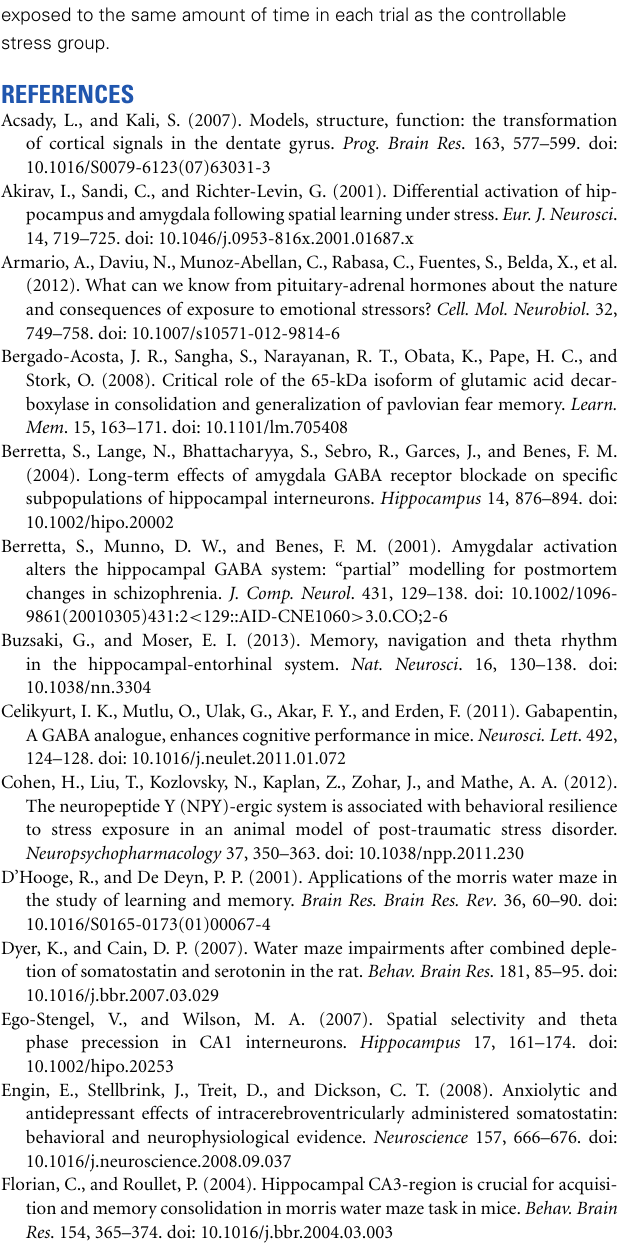
Figure S1 | “Invisible platform” learning curve. Adult male rats ( N = 10) underwent spatial learning in the Morris water maze for locating a hidden underwater platform in 12 trials ( ∼ 60min) with intertrial intervals of 4min. In all trials rats were allowed to search for the hidden platform for 60s at maximum with time measured until animal has reached the platform (escape latency). If an animal failed to reach the platform after 60s, it was placed and left there by the experimenter for 15–30s. The escape latency was assessed for each trial in order to gaining a learning curve for the controllable stress group. Animals of the uncontrollable stress group were exposed to the same amount of time in each trial as the controllable stress